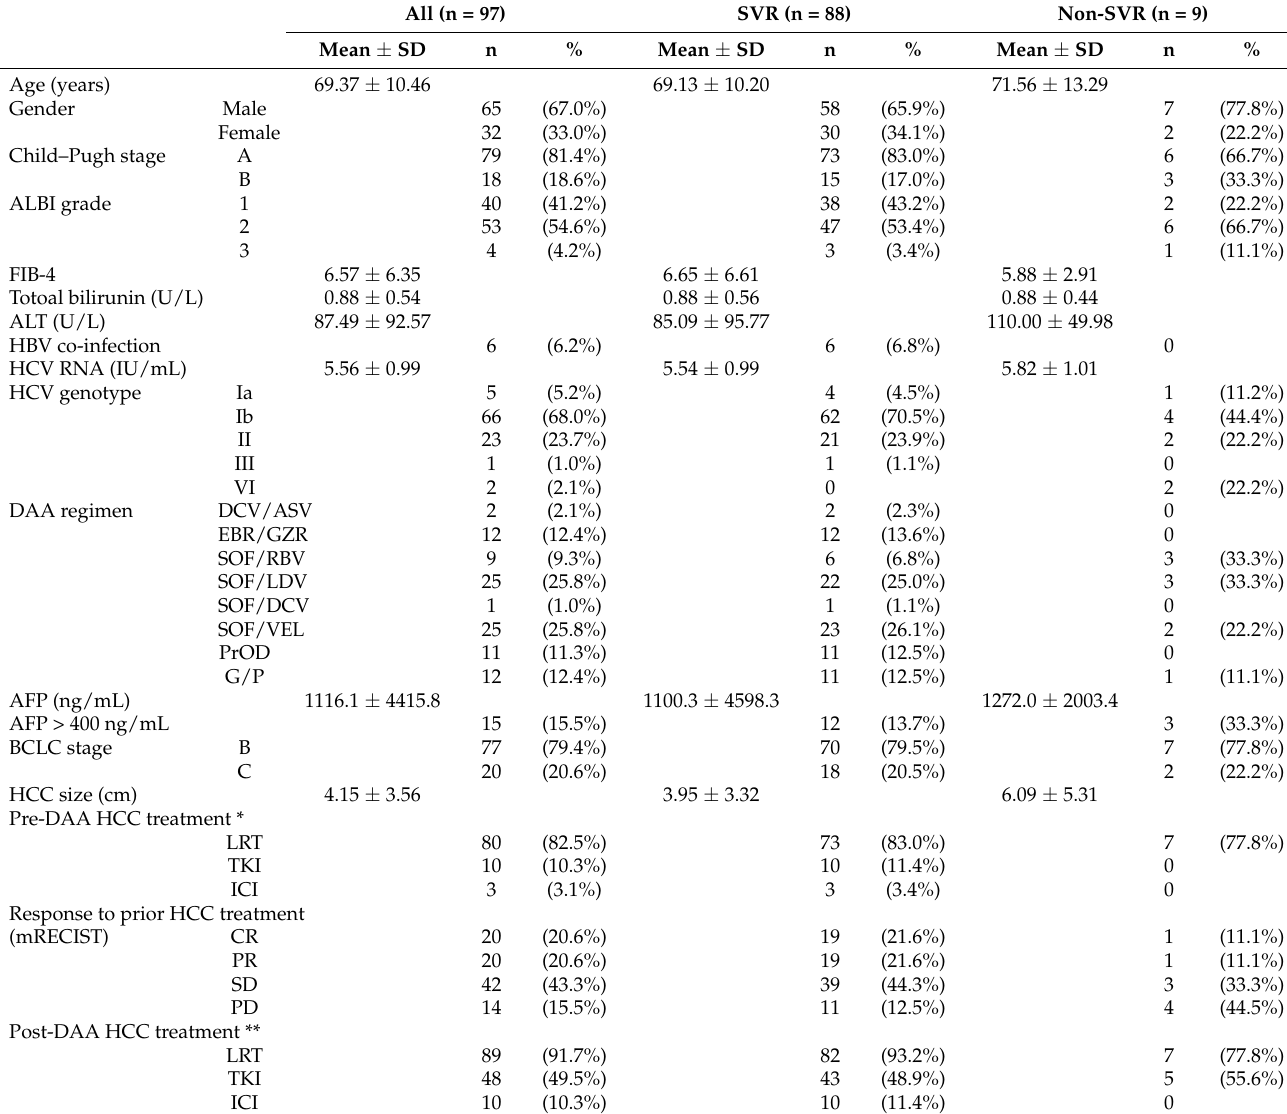
Table 1. Baseline characteristics in patients with SVR and